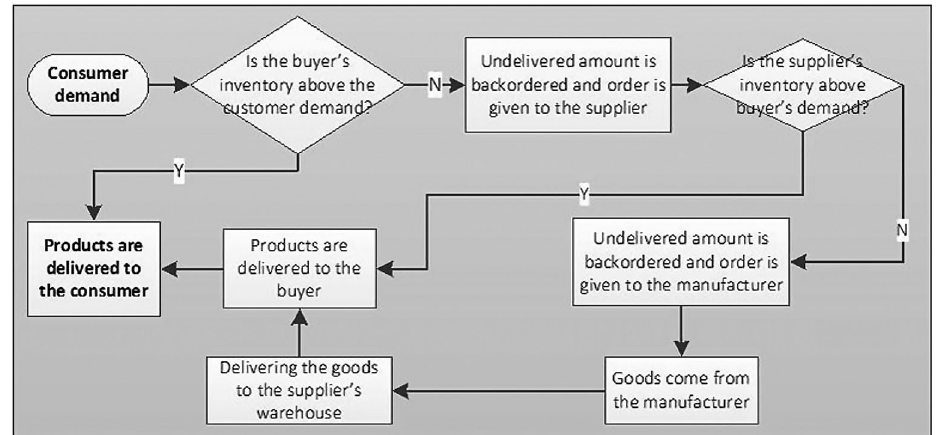
Fig. 1. Flow diagram for the traditional